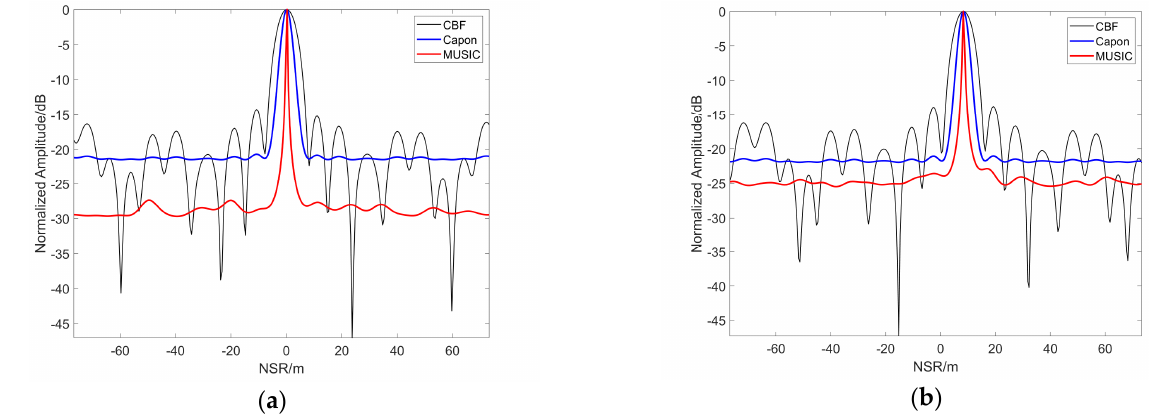
Figure 15. GCP point results with baseline number 20: ( a ) 1st point; ( b ) 55th point.